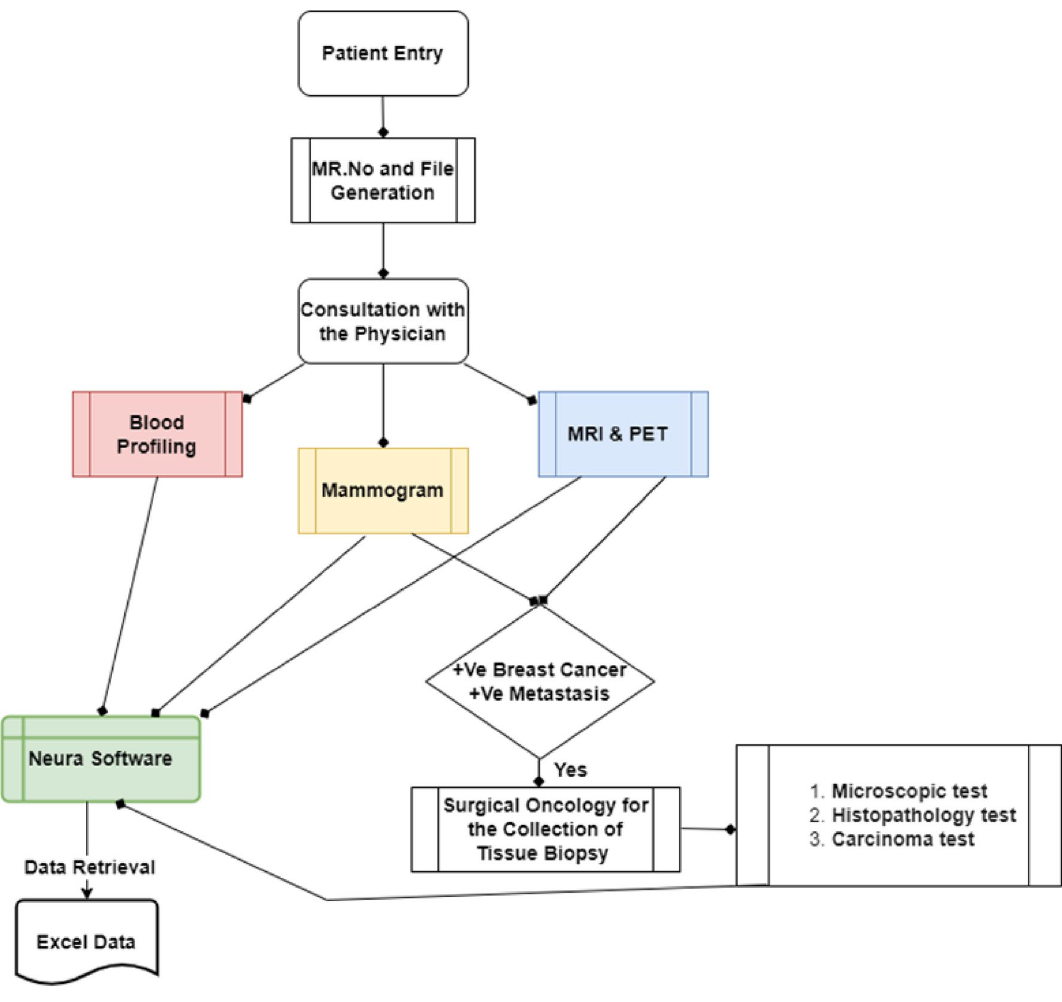
Figure 1. Data acquisition